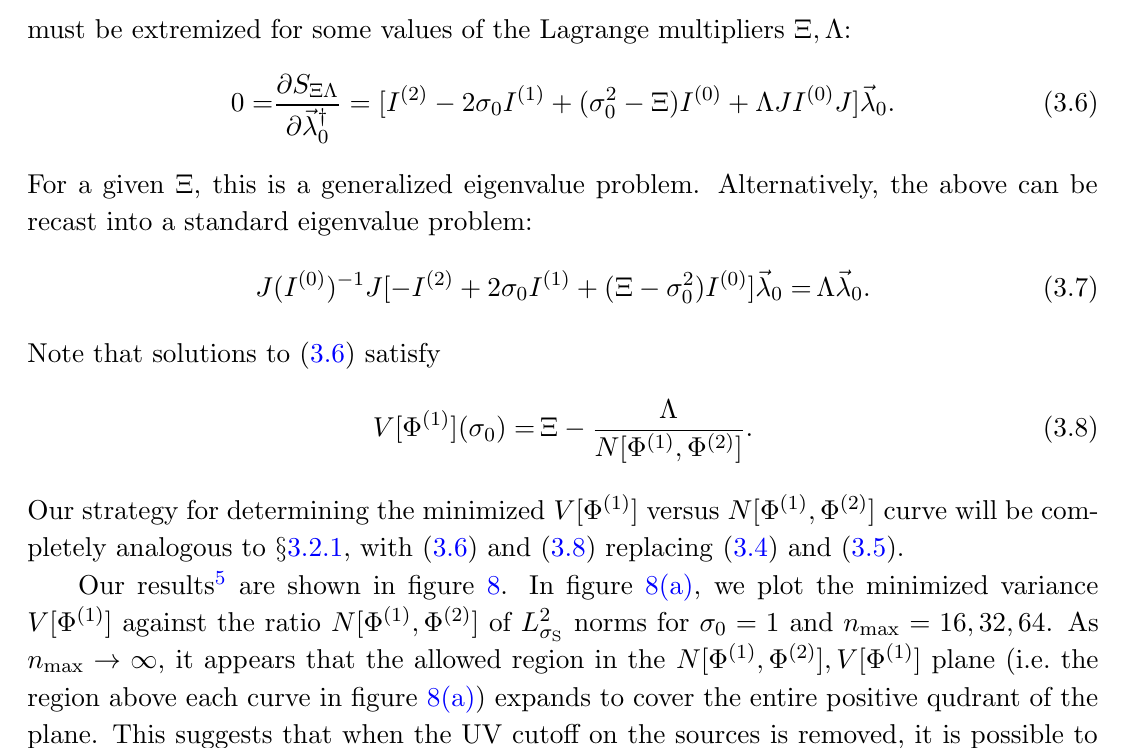
(b) Varying the location (cid:27) 0 about which (cid:8) (1) is (a) Varying the UV cuto(cid:11) n max on the source localized. modes. Figure 8. Minimization of the variance V [(cid:8) (1) ] of the initial data on one side of the black hole for (cid:12)xed ratios of L 2 norms between the initial data (cid:8) (1) ; (cid:8) (2) on the two sides of the black hole. (cid:27) S Shapes mark the absolute minima of V [(cid:8) (1)